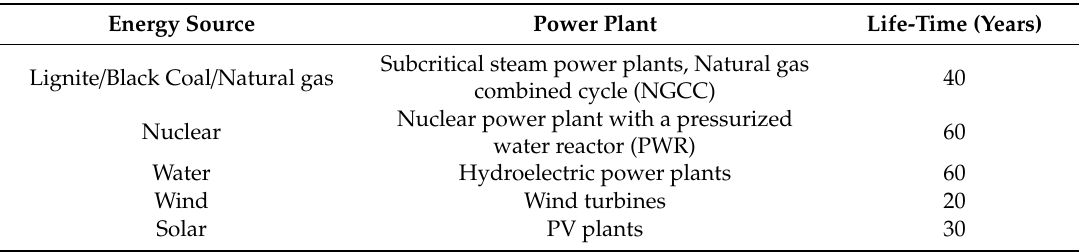
Table 3. The considered life-times of electricity sources according to the Product Category Rules Methodology